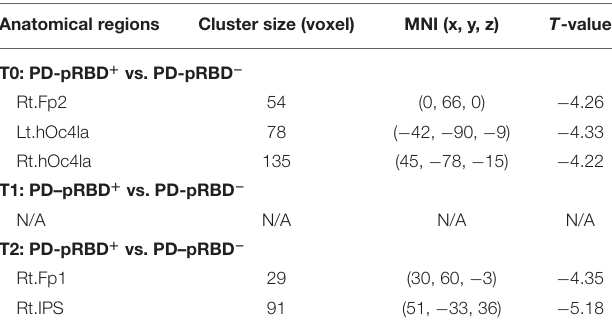
TABLE 2 | Functional connectivity alterations in the left DLPFC between patients with PD-pRBD + and PD-pRBD − over time. Anatomical